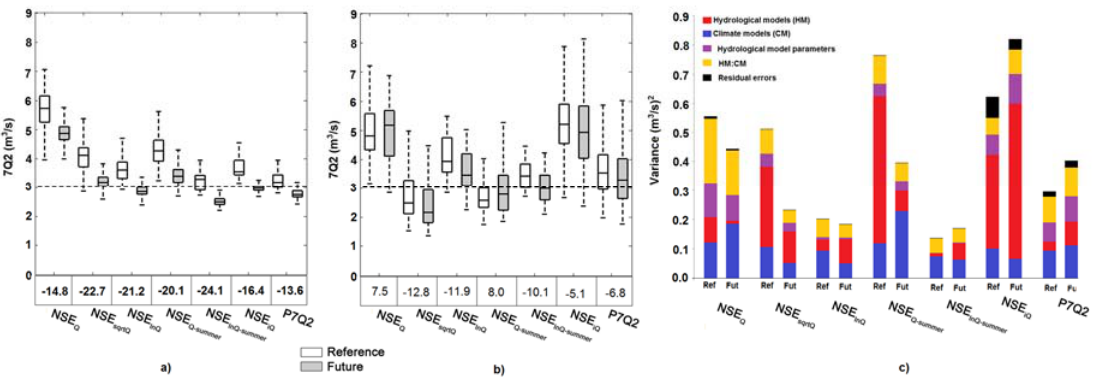
Figure 7. Uncertainties for the 7Q2 indices for the Farnham sub-watershed related to the climate model structure for the ( a ) GR4J; and ( b ) SWAT model; and ( c ) comparison of 7Q2 index variance for each source of uncertainty in reference (Ref) and future (Fut) periods for each objective functions.